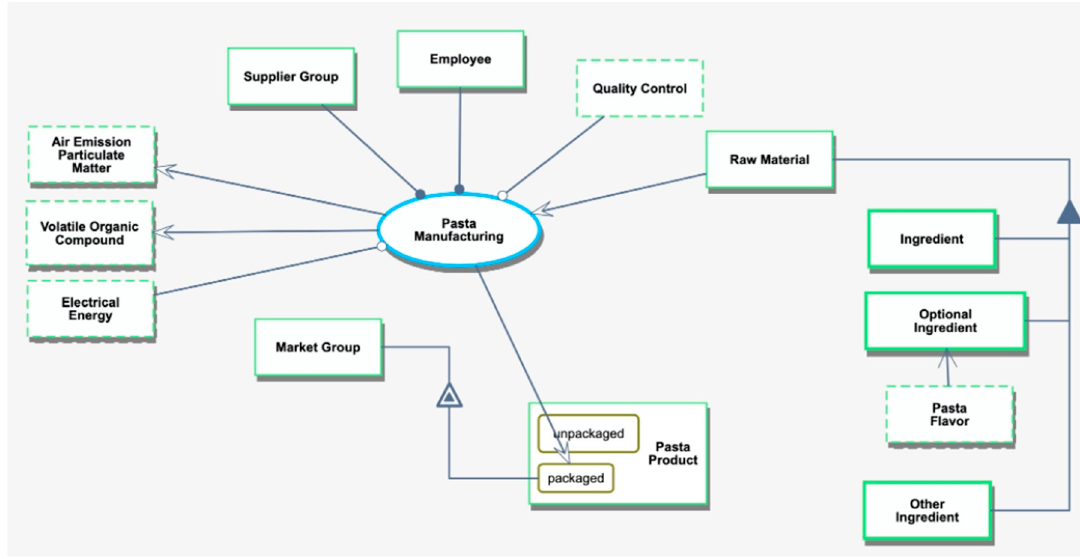
Figure A2. Model presented as part of the assignment submitted by participant #722122205.